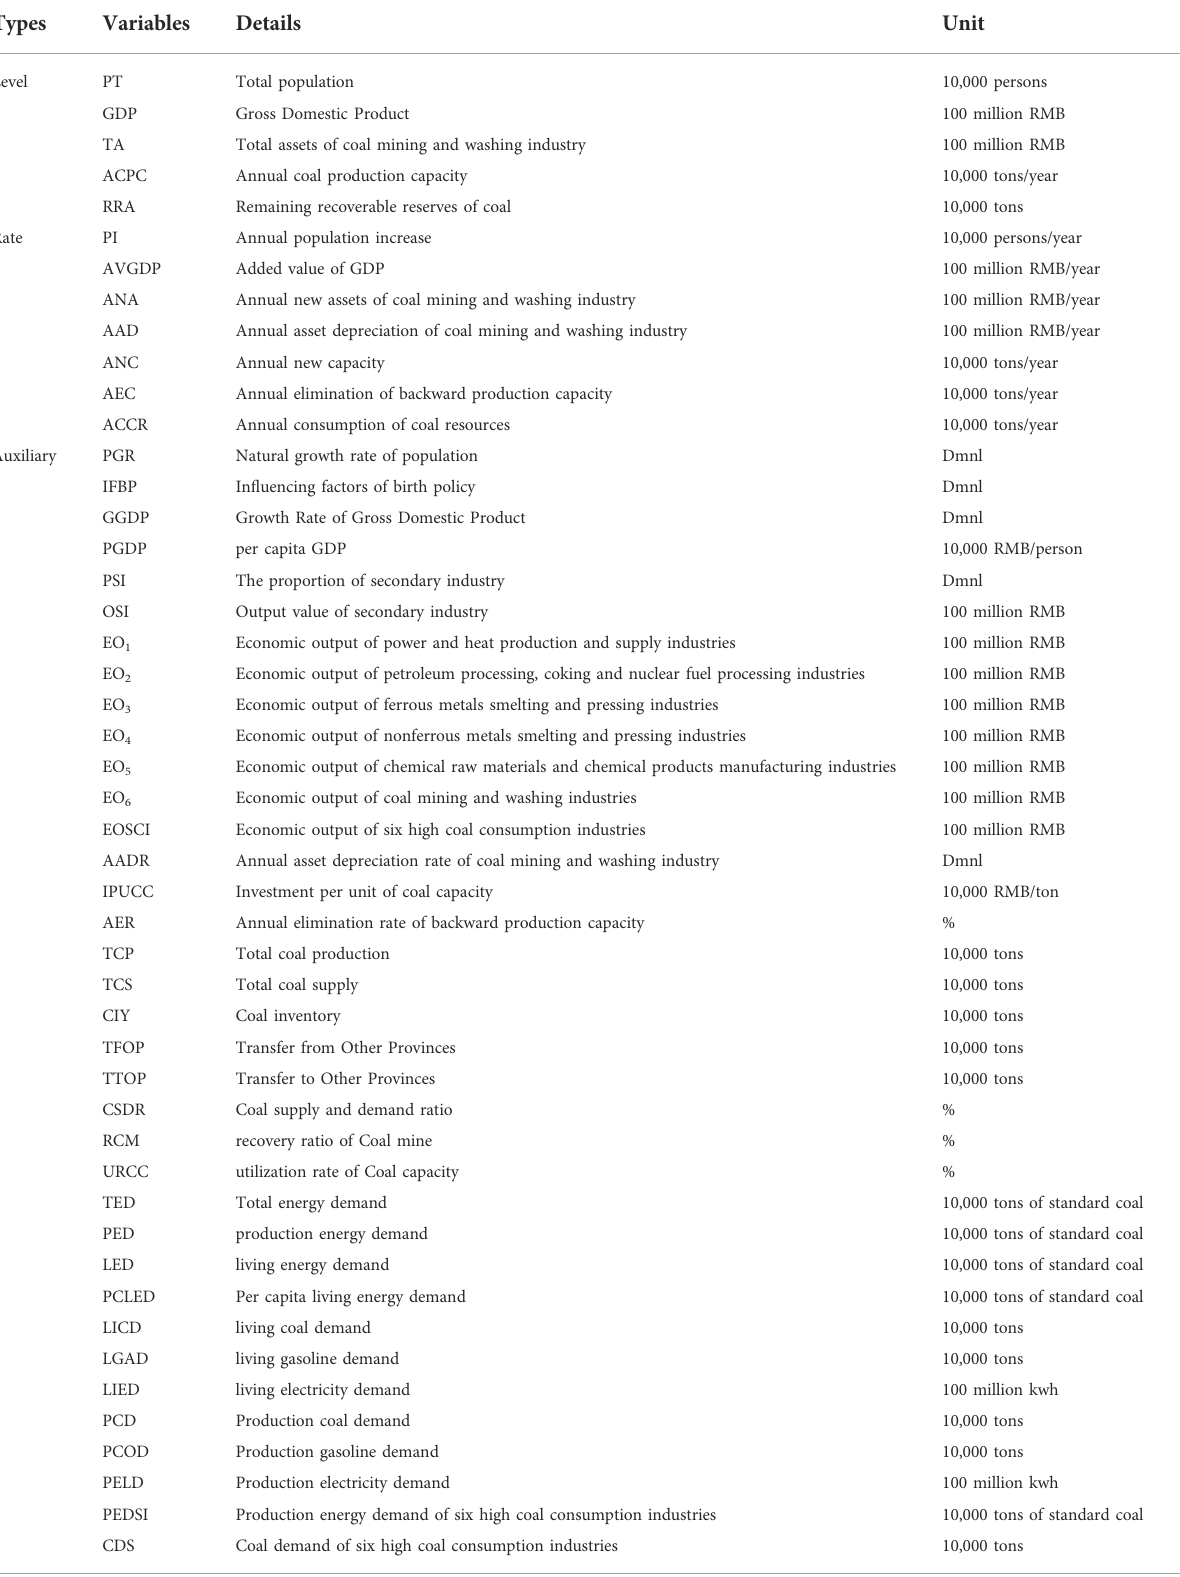
TABLE 2 Parameter settings in the